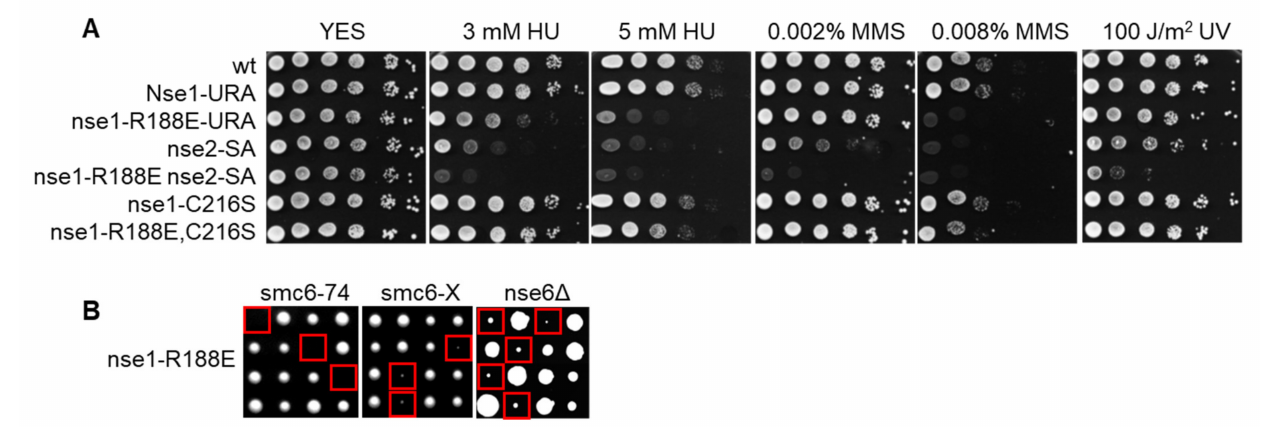
Figure 3. Nse1-R188E ubiquitin ligase mutant shows increased sensitivity to HU, MMS, and synthetic phenotypes with smc5/6 mutants. ( A ) Nse1-R188E strain is sensitive to HU and MMS. The indicated S. pombe strains were grown to OD 600 ~ 1, tenfold serially diluted, spotted onto rich media with the designated amounts of HU, MMS, or UV dose, and incubated at 28 ◦ C for 3 days. ( B ) Nse1- R188E mutant shows synthetic lethality with smc6-74 and severe growth defects with smc6-X and nse6 ∆ . Double mutants were analyzed by tetrad dissection of S. pombe diploid strains resulting from crosses between the strain carrying the nse1-R188E mutation and the indicated smc5/6 mutants. Red rectangles mark double